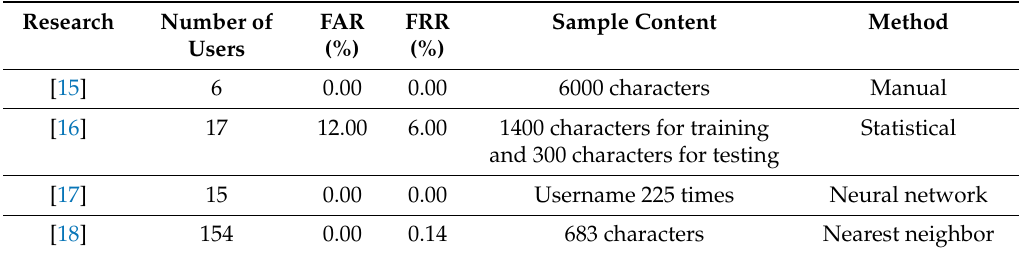
Table 1. Static methods for